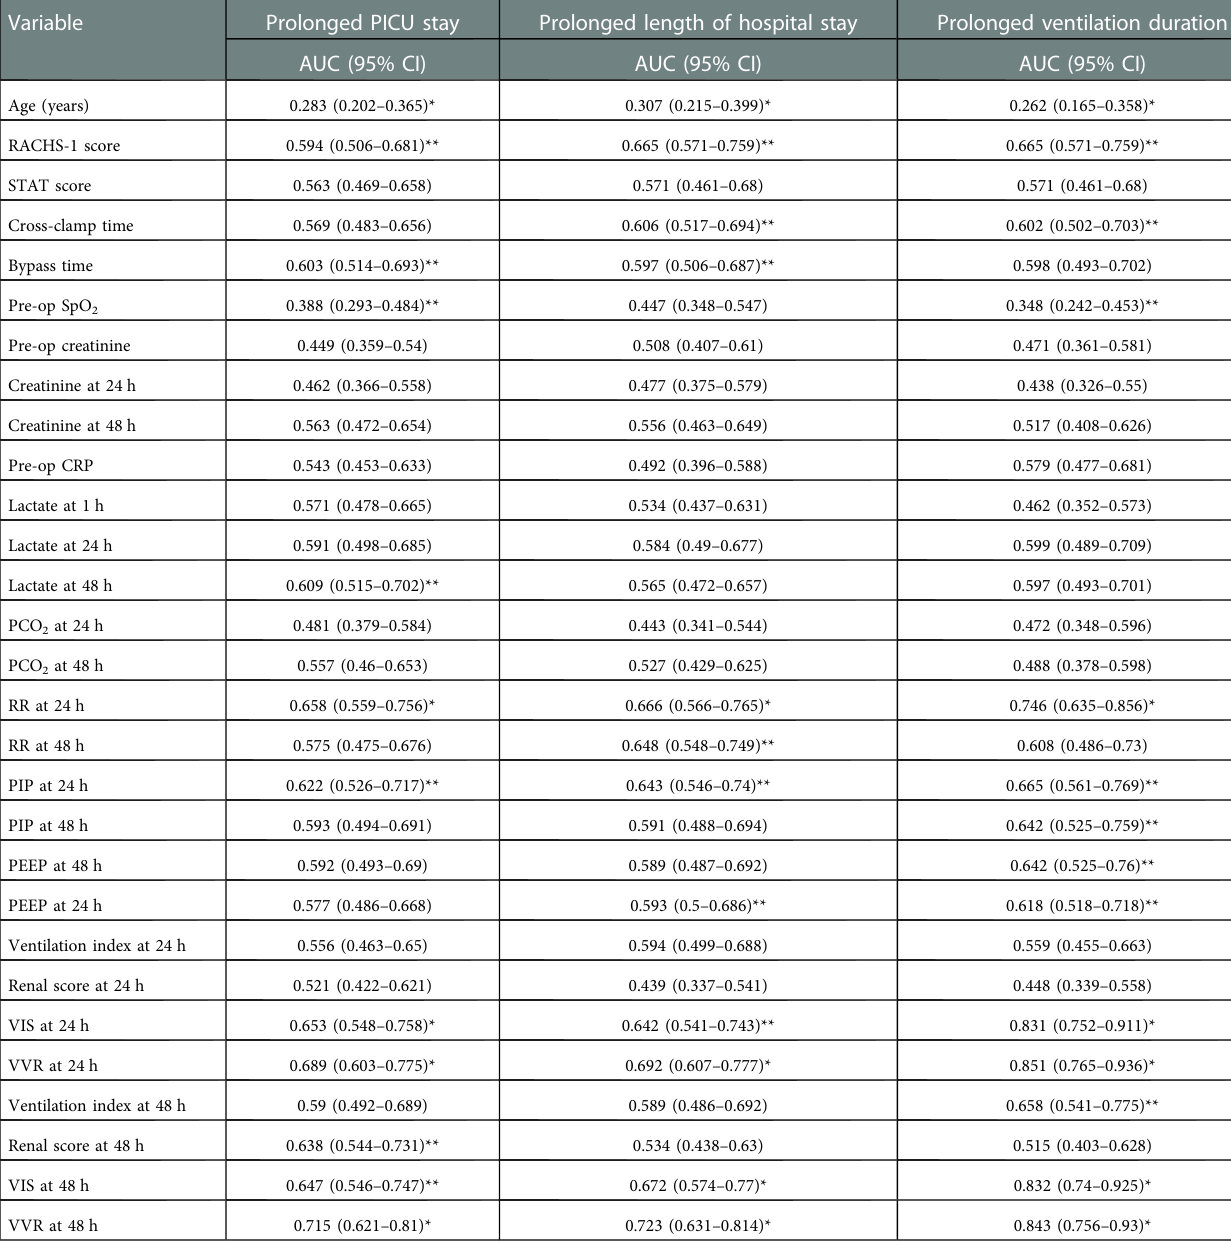
TABLE 4 Area under the ROC curve of different demographic and clinical variables for the outcomes of interest (prolonged PICU stay, prolonged length of hospital stay, and prolonged ventilation